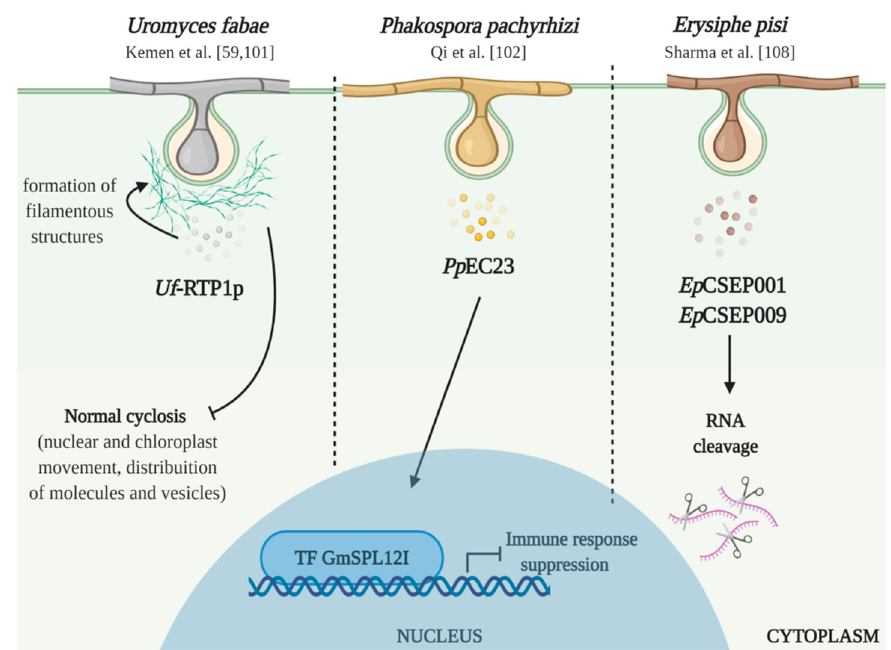
Figure 2. Effector proteins identified and characterized in legume crops. Uf -RTP1p released from U. fabae accumulates and forms filamentous like structures due to β -aggregation in the cytoplasm surrounding the haustorium. The P. pachyrhizi effector Pp EC23 effector interacts and possibly modulate post-translationally the soybean transcription factor Gm SPL12I, resulting in suppression of plant immunity. Gm SPL12I was shown to be a negative regulator of soybean defenses. Candidate secreted effectors Ep CSEP001 and Ep CSEP009 from E. pisi are analogous to RNase-like proteins and may express RNA cleavage activity (created with BioRender.com).